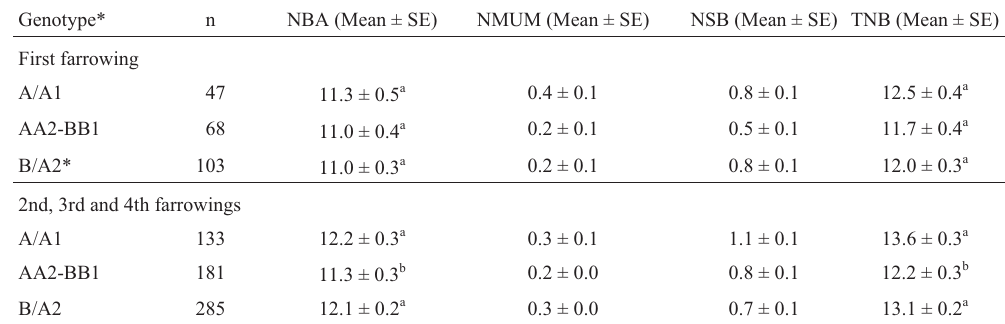
*AnimalswereclassifiedaccordingtogenotypeintoAA,BB(homozygous)orAB(heterozygous)for ER -PvuIIandA1orA2for RBP4 -MspI(seeMate- rial and Methods for details). A/A1 = animals carrying ER -PvuII allele A (genotype AA or AB) and RBP4 -MspI genotype A1; AA2-BB1 = animals ho- mozygousfor ER -PvuII(genotypeAAorBB)andA1orA2 RBP4 -MspIgenotype;B/A2=animalscarrying ER -PvuIIalleleBand RBP4 -MspIgenotype A2. ab In the same column values with different letters are significantly different at (p <